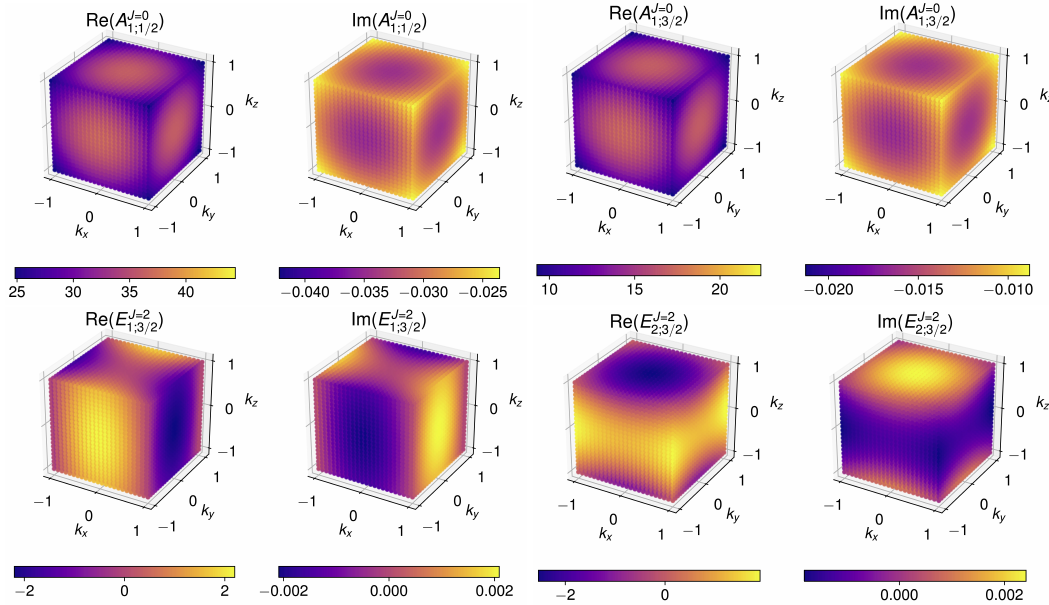
Figure 6: Momentum space distribution of the superconducting states arising from the novel Kondo interaction of even parity presented in Table 2 and Fig. 2.